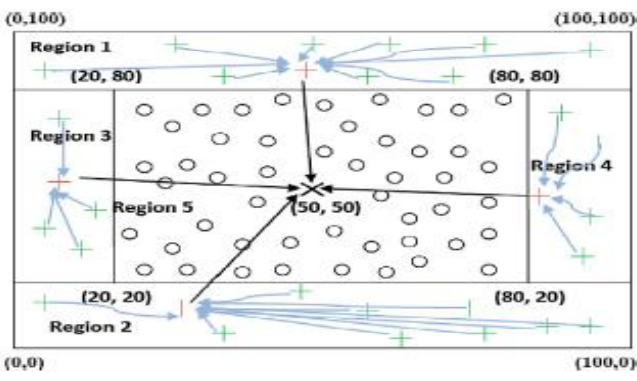
Figure 1. Deployment of Nodes in Sensing